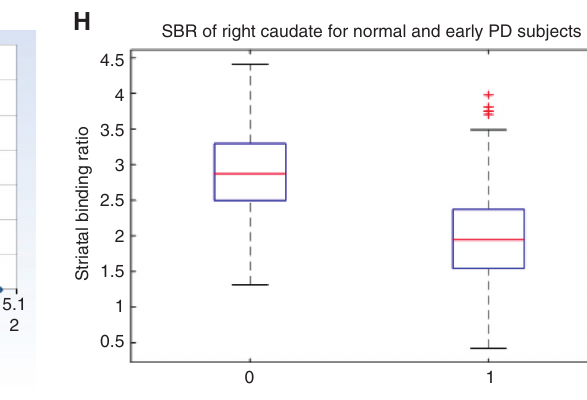
Histogram: SBR of right caudate for normal and PD subjects Box plot-SBR of right caudate for normal and PD subjects